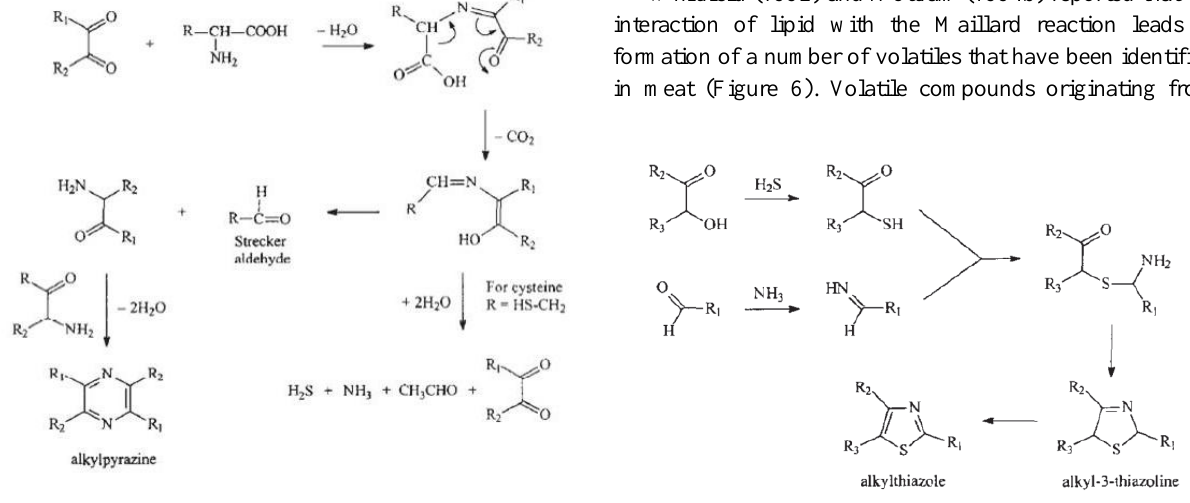
Figure 5. Mechanism for the formation of thiazolines and thiazoles in the Maillard reaction (Mottram,